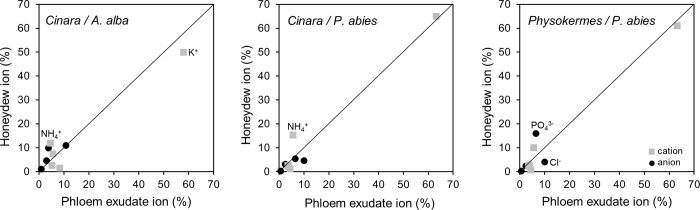
Inorganic ions in phloem exudate and honeydew, each expressed as percentage of the total inorganic ion concentration.Cinara species feeding on A. alba, Cinara species feeding on P. abies, and Physokermes species feeding on P. abies. The data show means across both species of a hemipteran genus feeding on the same tree species for the proportion of inorganic ions in honeydew (data from Table 3). Points with the highest orthogonal distance to the bisecting line were noted. Grey squares: cations, black circles: anions.